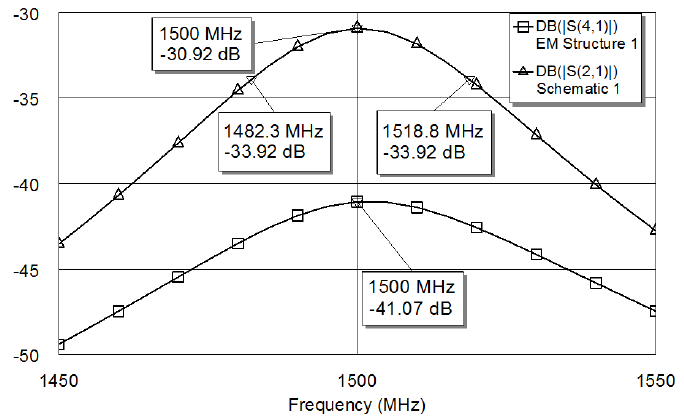
Fig. 4. The results of modeling the transmission of a microwave signal by a passive and active antenna element.